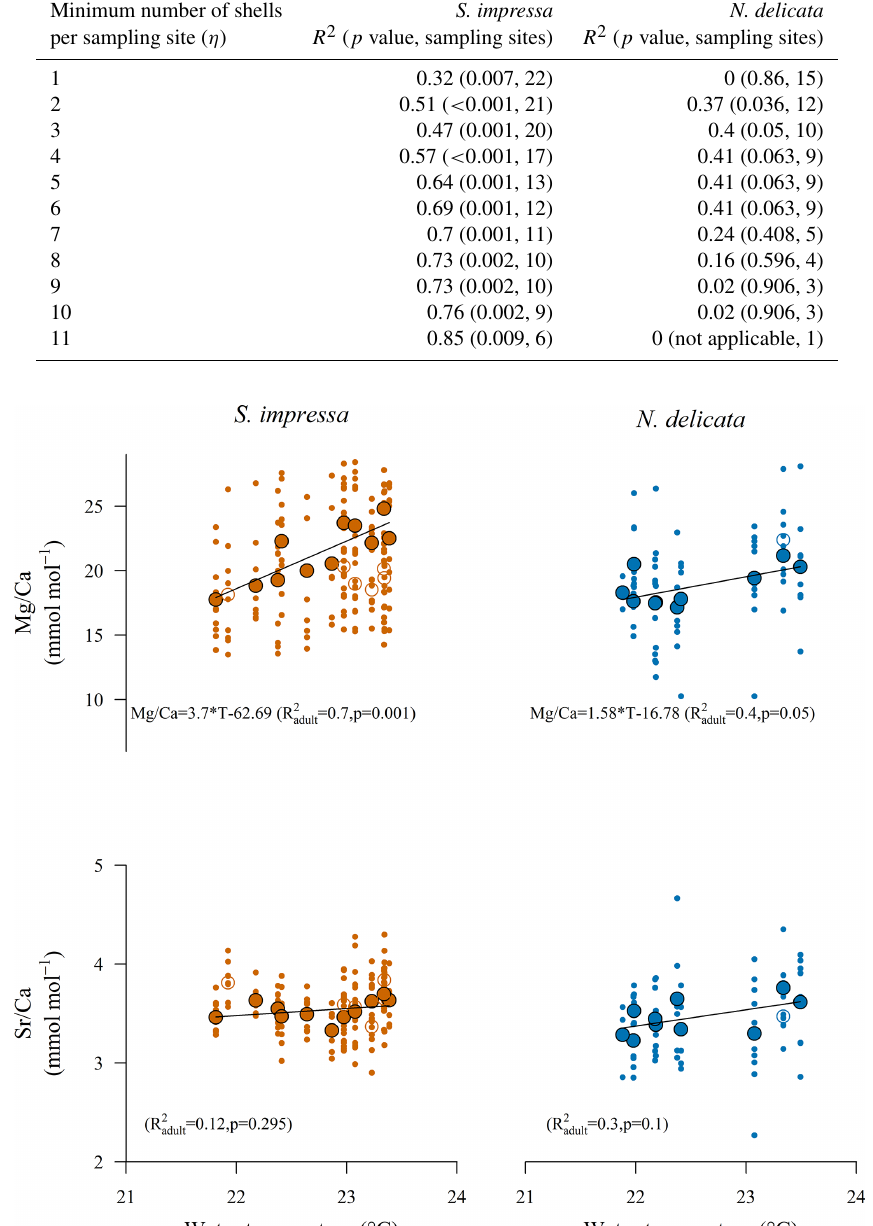
Figure 2. Relationships of Mg / Ca and Sr / Ca with annual temperature for adult (filled circles) and A-1 juvenile (open circles) ostracod samples of S. impressa ( η = 7) and N. delicata ( η = 3). Single-shell samples are shown as small dots. Solid lines show the linear regressions for adult